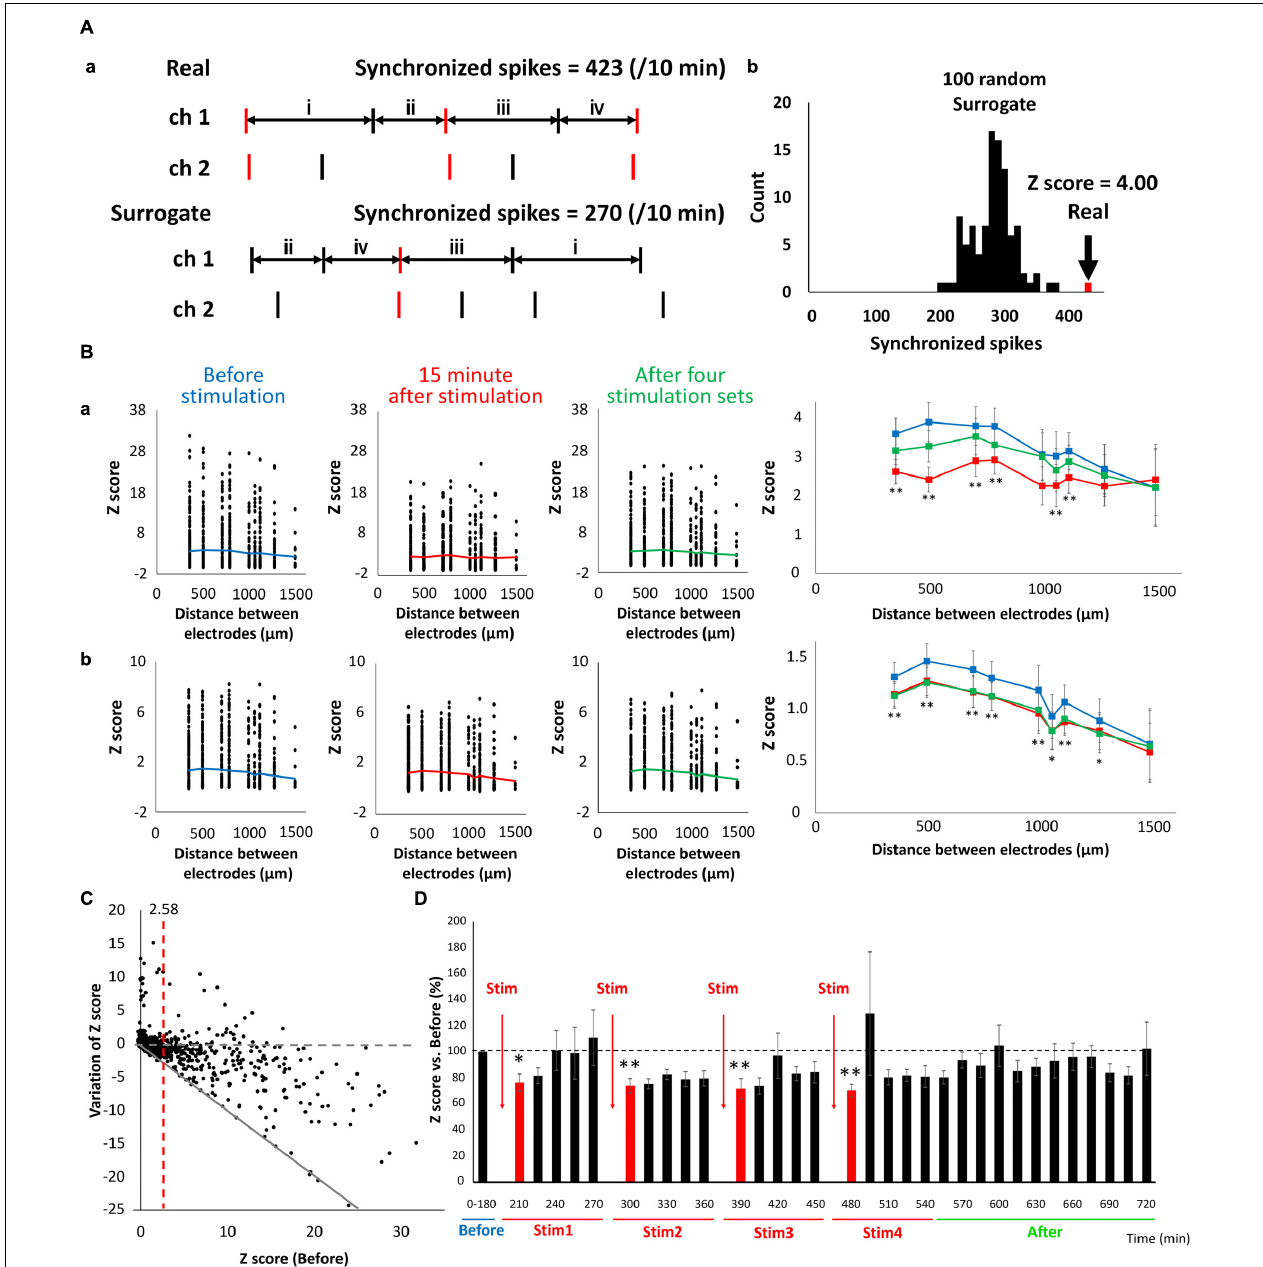
FIGURE 6 | Reduction of connection strength in neuronal network caused by LFS. (A) Count of synchronized spikes between two electrodes. The number of synchronized spikes for every 15 min was counted within a 100 ms spikes (red). (a) Typical spike patterns of two electrodes (top). Each vertical line represents each spike. Typical surrogate dataset was generated by transposing the interspike intervals (ISIs) at random within an electrode (bottom). (b) Histogram of number of synchronized spikes. A real synchronized spikes is indicated by the arrow, which was compared with the distribution of synchronized spikes computed from the corresponding 100 surrogate datasets (black histogram). Based on the distribution of the surrogate datasets, the Z -score of the real data was computed to be 4.00. (B) The distribution of Z -score for each electrode distance ( n = 120 pairs/well × 8 well = 960). The black plot shows the Z -score of each pair of electrodes; the polygonal line shows its average; (a) shows the data of sporadic firings that are not synchronized (sporadic); and (b) shows the data of synchronized bursts (burst) (blue; before, red; 15 min immediately after LFS, green; after 4 stimulation sets, n = 8). Right graphs show the average of Z -score before, 15 min immediately after LFS and after 4 stimulation sets in sporadic firings (upper) and burst firings (lower), respectively (two-tailed paired t -test, ∗ p < 0.05, ∗∗ p < 0.01 vs. before stimulation). (C) Distribution of variation of Z -score in sporadic spikes before and after LFS ( n = 120 pairs/well × 8 well = 960). Variation value of Z -score defined Z -score (15 min immediately after LFS)— Z -score (before LFS). Gray dashed line shows variation of Z -score was zero (not affected by LFS), and gray line shows Z -score became zero after LFS. Red line indicates Z -score (before stimulation) = 2.58, which represents a significance level of P < 0.05. (D) Change in the Z -score versus before (%) (sporadic spikes, n = 8). Black bars show Z -score for every 15 min, and red bars show Z -score for 15 min immediately after LFS. Data were analyzed using one-way ANOVA followed by post hoc Dunnett’s test ( ∗ p < 0.05, ∗∗ p < 0.01 vs.